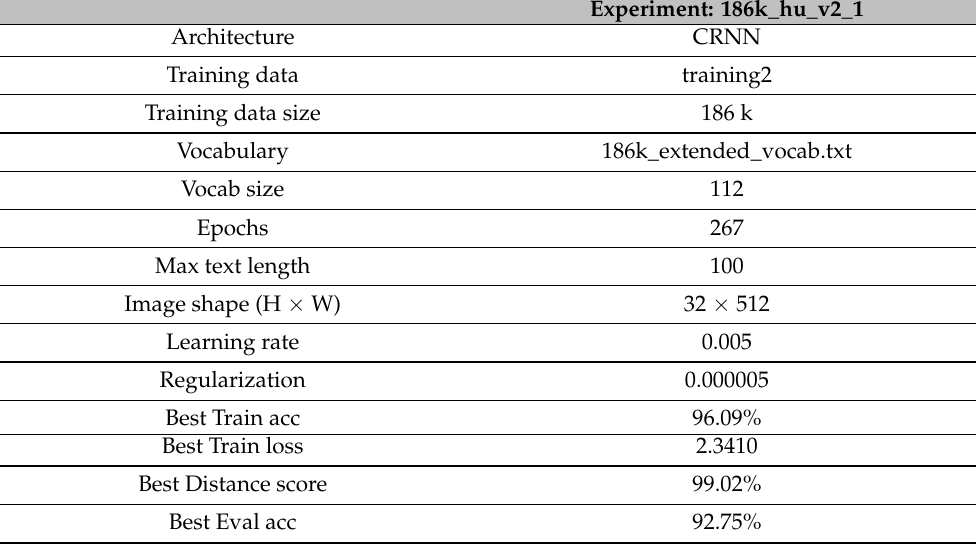
Table 8. Hungarian with parameter